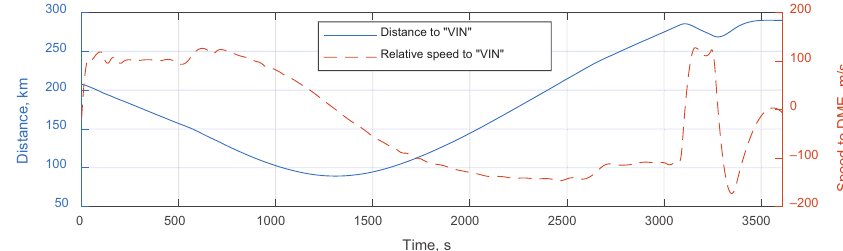
Figure 4. Distance from an aircraft to “VIN” DME during the flight “AUI79” and their mutual